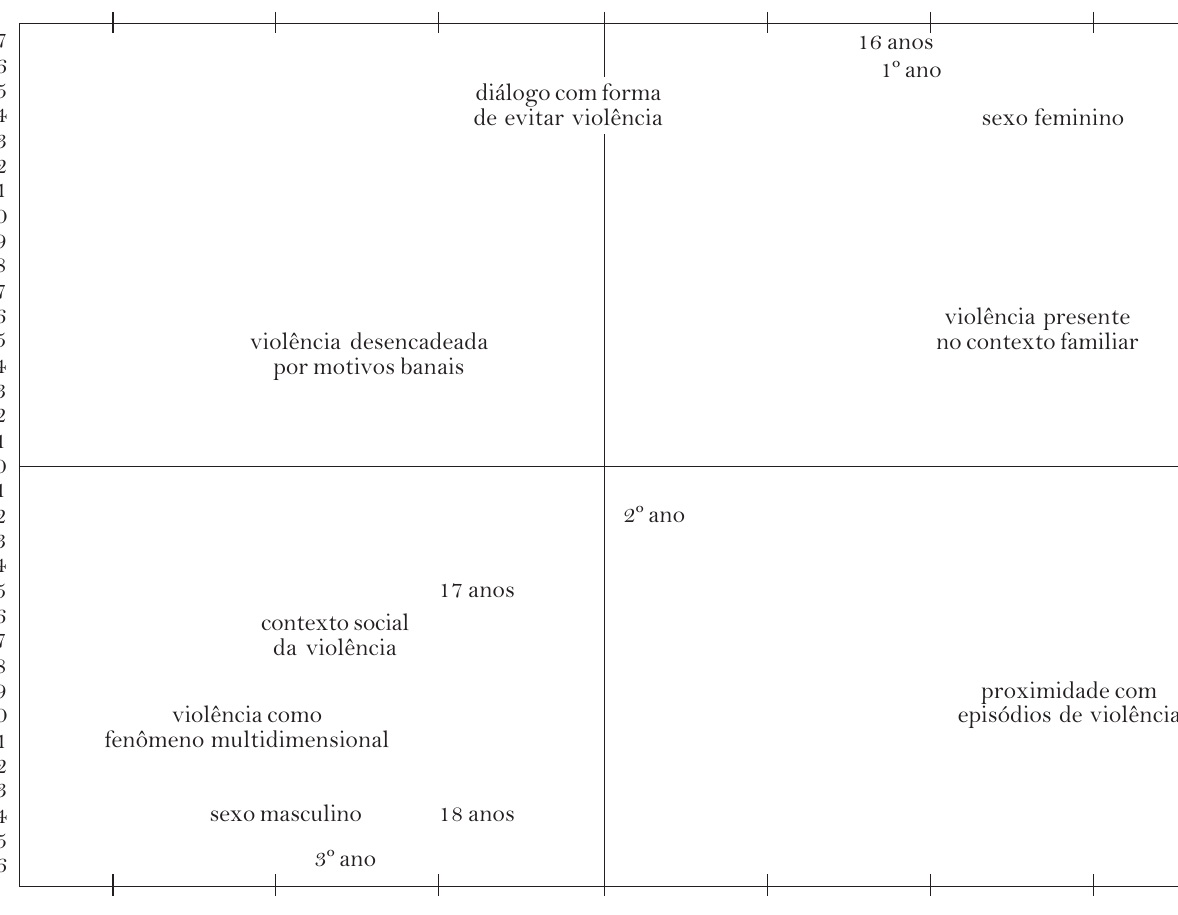
Figura 2 apresenta o Plano Fatorial contendo a projeção das variáveis e das seis classes examinadas anteriormente. Em razão da compreensibilidade dos resultados as pala- vras mais “freqüentes” (de maior Qui-quadrado associativo) de cada classe não são apresentadas no plano fatorial. A distribuição não aleatória destes elementos em diversas zonas do Plano Fatorial possibilita a percepção de duas grandes dimensões acerca da violência.